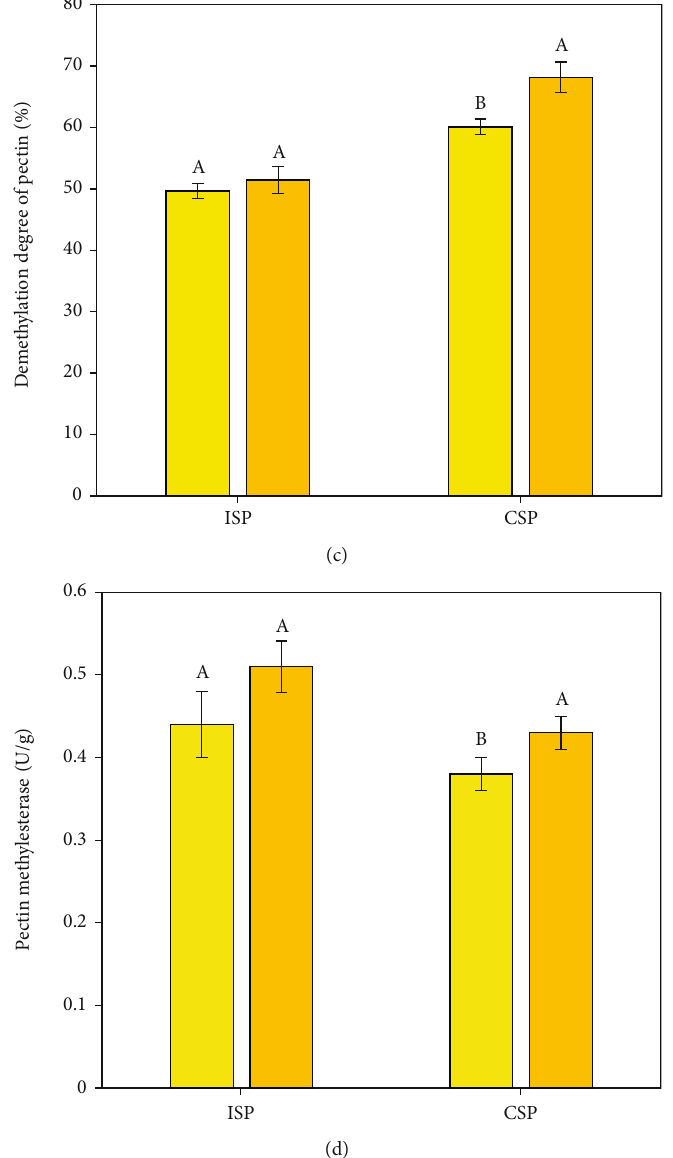
Figure 4: The e ff ects of IDS on CW components, Cd content in CW components, and pectin demethylation in rapeseed leaves. Mean ± SD ( n = 5 ). Di ff erent uppercase letters (A, B) indicate signi fi cant di ff erence between CK and IDS treatment at P < 0 : 05